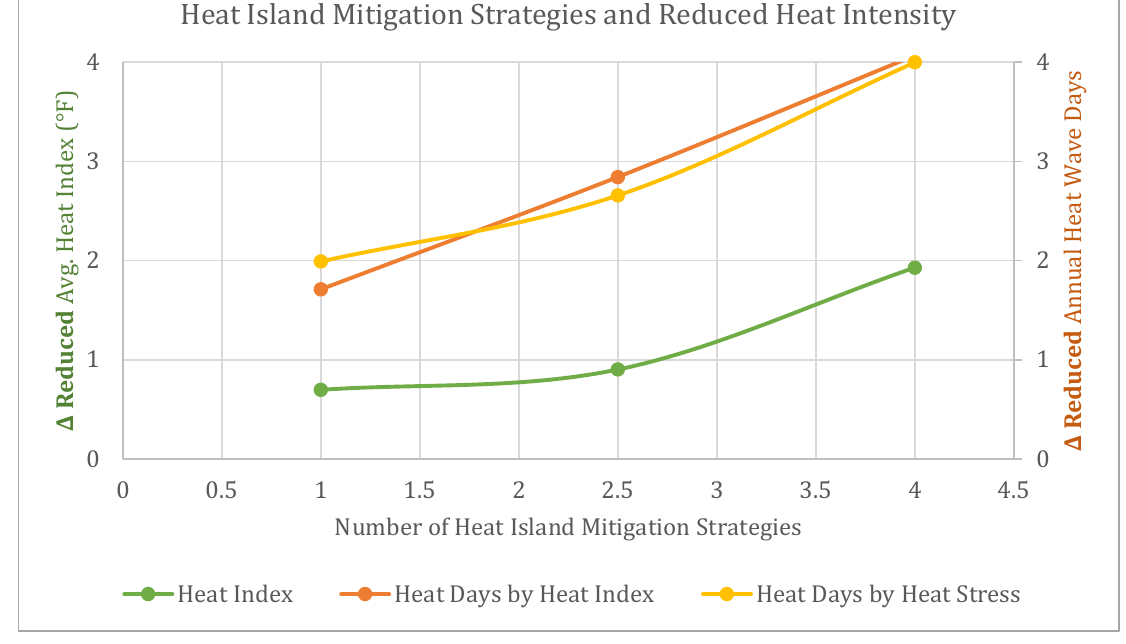
Figure 4. The heat-hazard-lowering effects of heat island mitigation strategies.